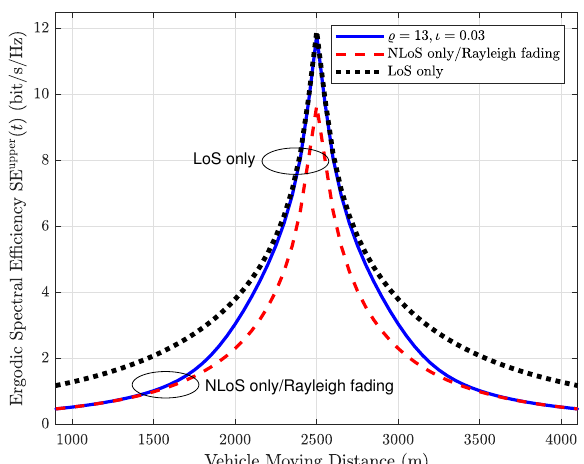
Figure 4. Ergodic SE for one vehicle pass with distance-dependent Rician factor ( (cid:36) = 13, ι = 0.03) [20], LoS Rician factor ( (cid:36) = 10 2 , ι = 0), and NLoS Rician factor ( (cid:36) = − 10 2 , ι = 0).